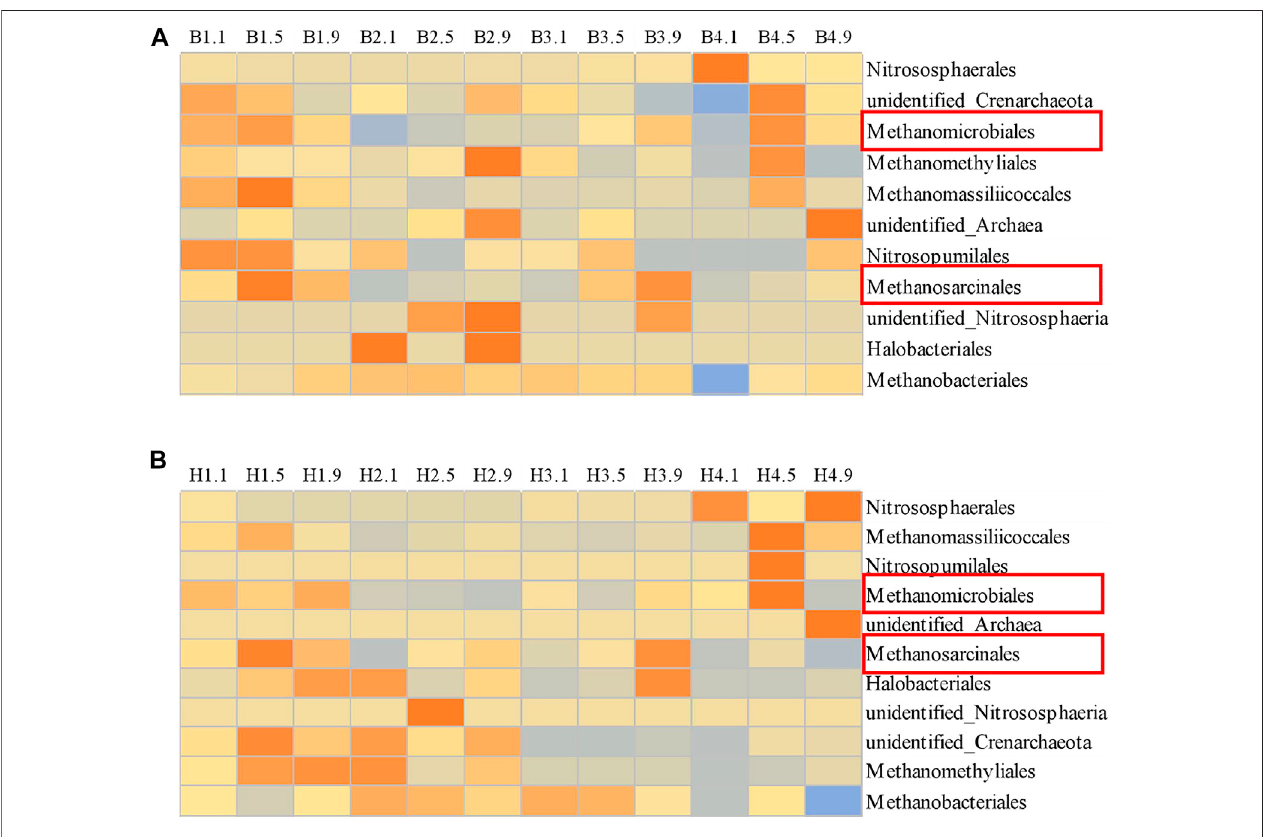
FIGURE 6 | Composition of archaea community in each layer of CB (A) and CH (B)